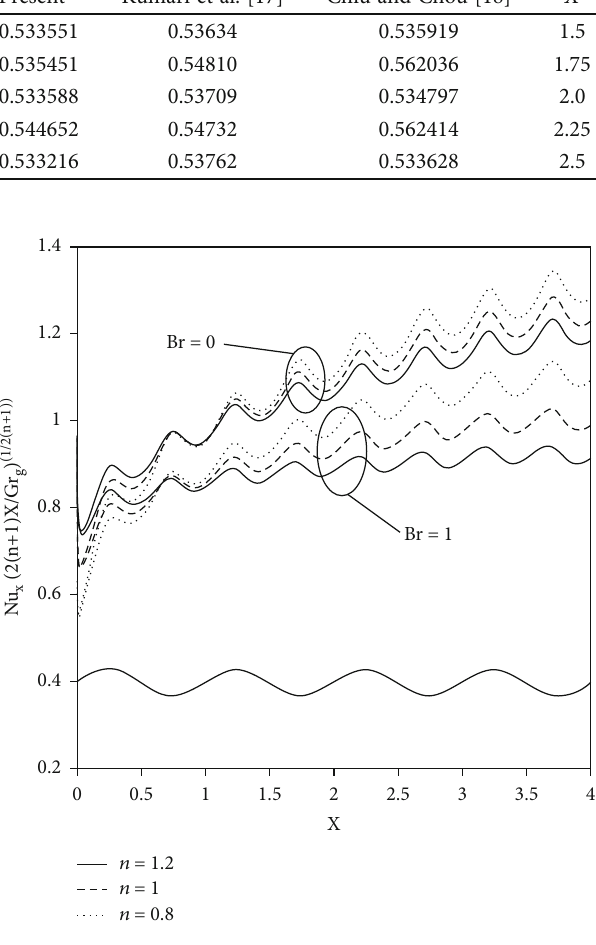
Figure 3: The axial distribution of the local Nusselt number